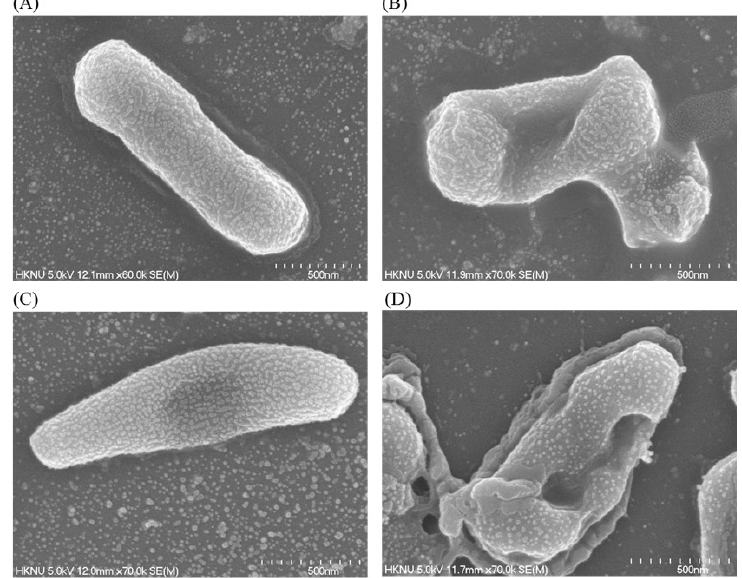
Figure 11. SEM images of normal E. coli cells ( A ), 1 × MBC AgNPs treated E. coli cells ( B ), normal P. aeruginosa cells cells ( C ), and 1 × MBC AgNPs treated P. aeruginosa cells cells ( D ).